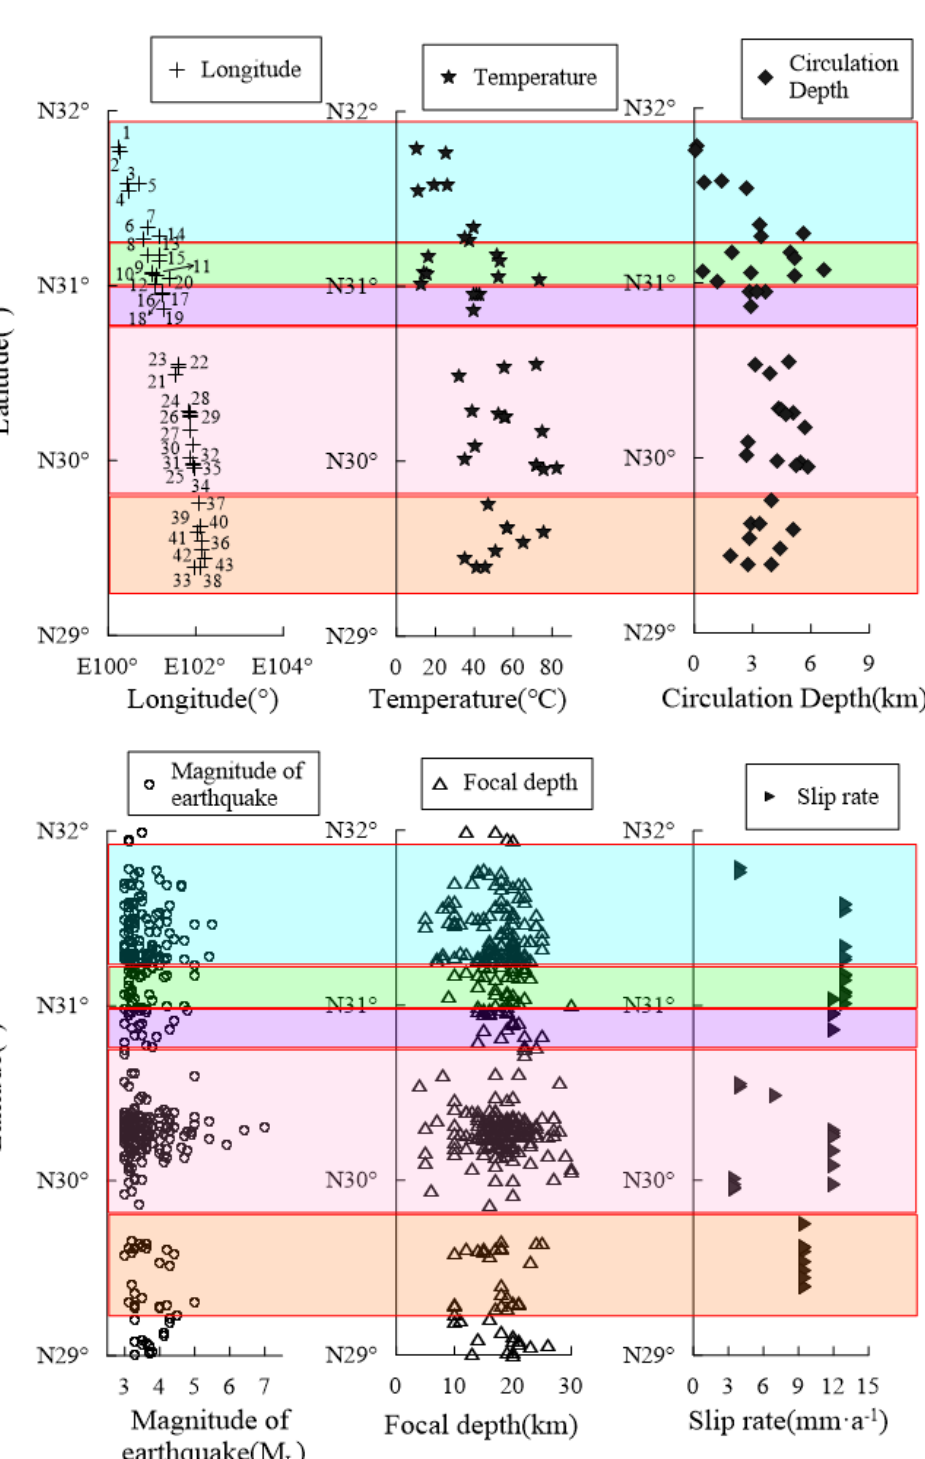
Figure 8. The spatial distribution of temperature, the depth of circulation of 43 hot springs and slip rates, magnitudes and focal depths in the XSHF. The different colours represent different areas of the Xianshui River Fault Zone, with blue representing the Zhuwo and Luhuo segment, Green representing the Daofu segment, Rose representing the Bamei segment, Light red representing the Kangding segment, Orange representing the Moxi segment.